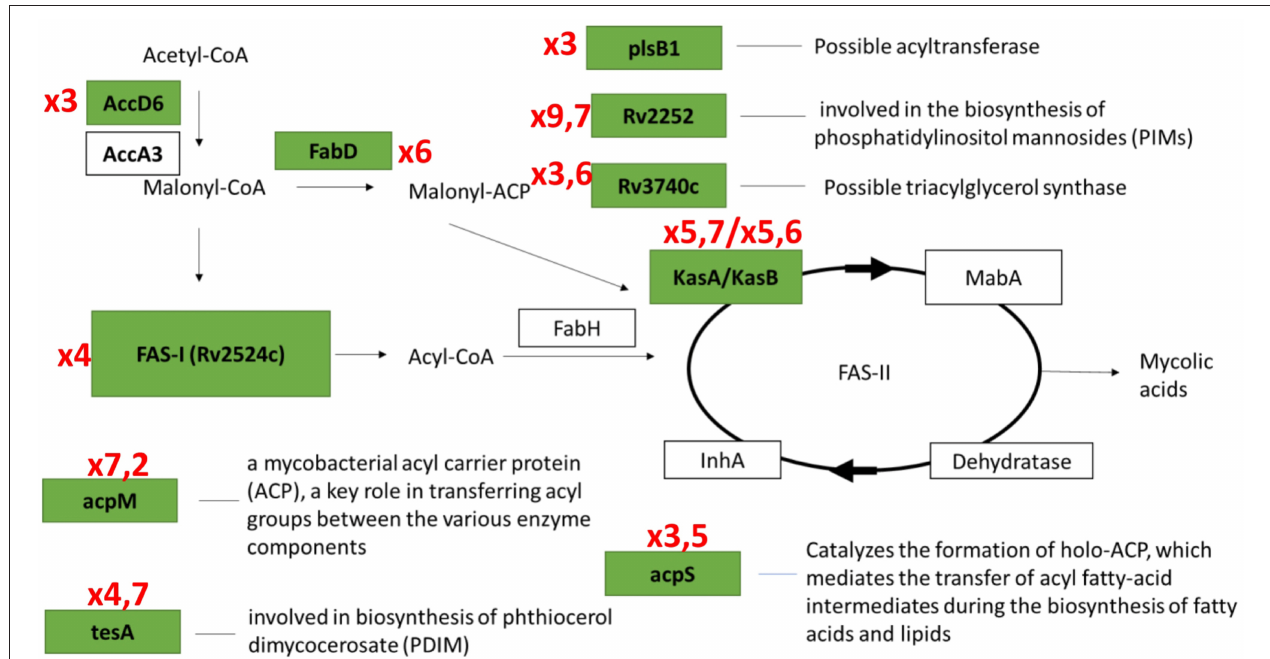
FIGURE 7 | Transcriptional activation of genes involved in fatty acids biosynthesis systems (FASI/FASII) in the early resuscitation phase. Components upregulated at Day1 are given in green boxes. Red numbers designate transcriptional fold changes comparing to dormant NC state.